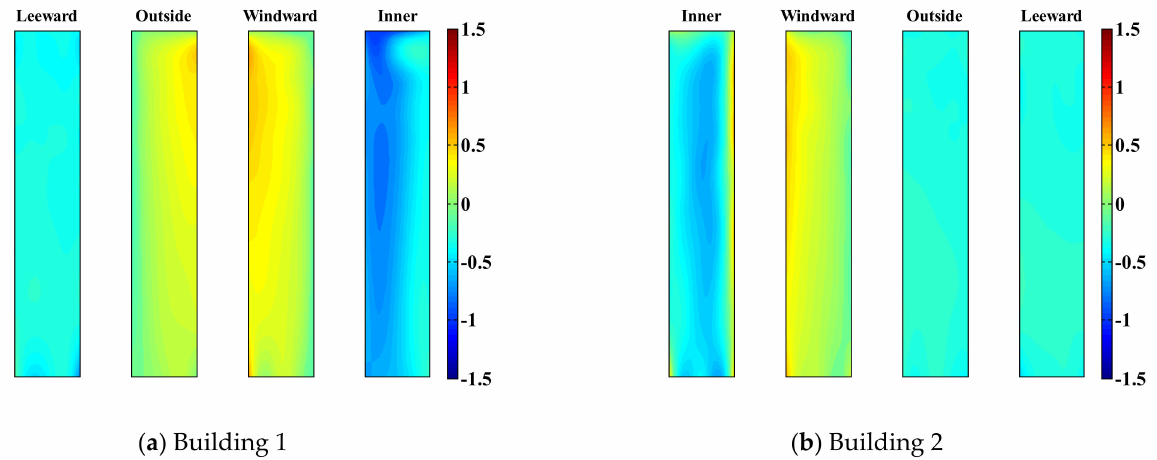
Figure 9. Mean pressure distributions of two buildings with a small gap distance.